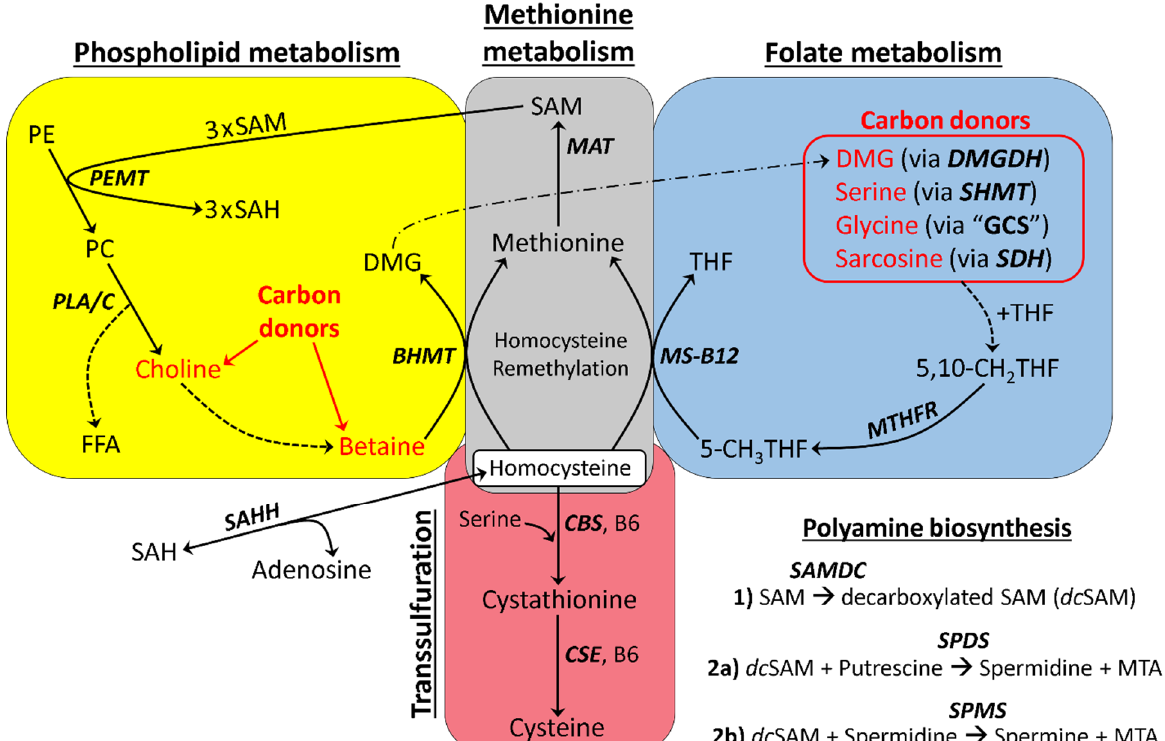
Figure 1. Simplified model of one-carbon metabolism: The irreversible oxidation of Hcy to cystathionine requires the B6-dependent enzyme CBS. Likewise, the oxidation of cystathionine to cysteine requires the B6-dependent enzyme CSE. The BHMT reaction utilizes betaine (which is derived from choline) as a methyl group donor, while MS-B12 utilizes 5-CH 3 THF as a methyl group donor. Specific molecules (e.g., DMG, serine, glycine, and sarcosine) act as carbon donors in the presence of THF to form 5,10-CH 2 THF in the folate cycle. 5,10-CH 2 THF contributes directly or indirectly (depending on mitochondrial or cytosolic localization) to the formation of 5-CH 3 THF, via MTHFR. After Hcy is remethylated via BHMT or MS-B12, the newly formed Met can be adenosylated via MAT to form SAM. Three molecules of SAM are consumed via the PEMT reaction, which produces one molecule of PC and three molecules of SAH. SAH is then hydrolyzed via the bidirectional enzyme SAHH, to yield adenosine and Hcy. BHMT = betaine homocysteine methyltransferase; CBS = cystathionine beta synthase; CSE = cystathionase; dc SAM = decarboxylated SAM; DMG = dimethylglycine; FFA = free fatty acid; Hcy = homocysteine; Met = methionine; MS-B12 = methionine synthase complexed with vitamin B12; MTA = methylthioadenosine; MTHFR = methylene tetrahydrofolate reductase; PC = phosphatidylcholine; PE = phosphatidylethanolamine; PLA/C/D = phospholipase A, C, or D; SAH = S-adenosylhomocysteine; SAHH = S-adenosylhomocysteine hydrolase; SAM = S-adenosylmethionine; SAMDC = SAM decarboxylase; SPDS = spermidine synthase; SPMS = spermine synthase; THF = tetrahydrofolate.